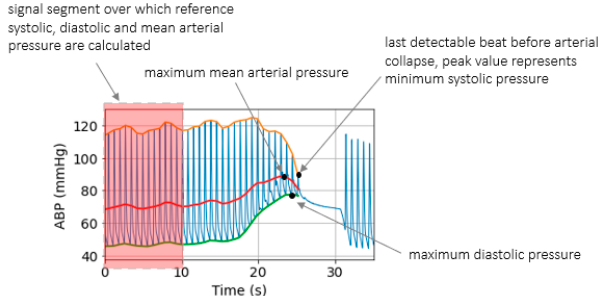
Figure 6. Illustration showing reference P sys , P dia , MAP.